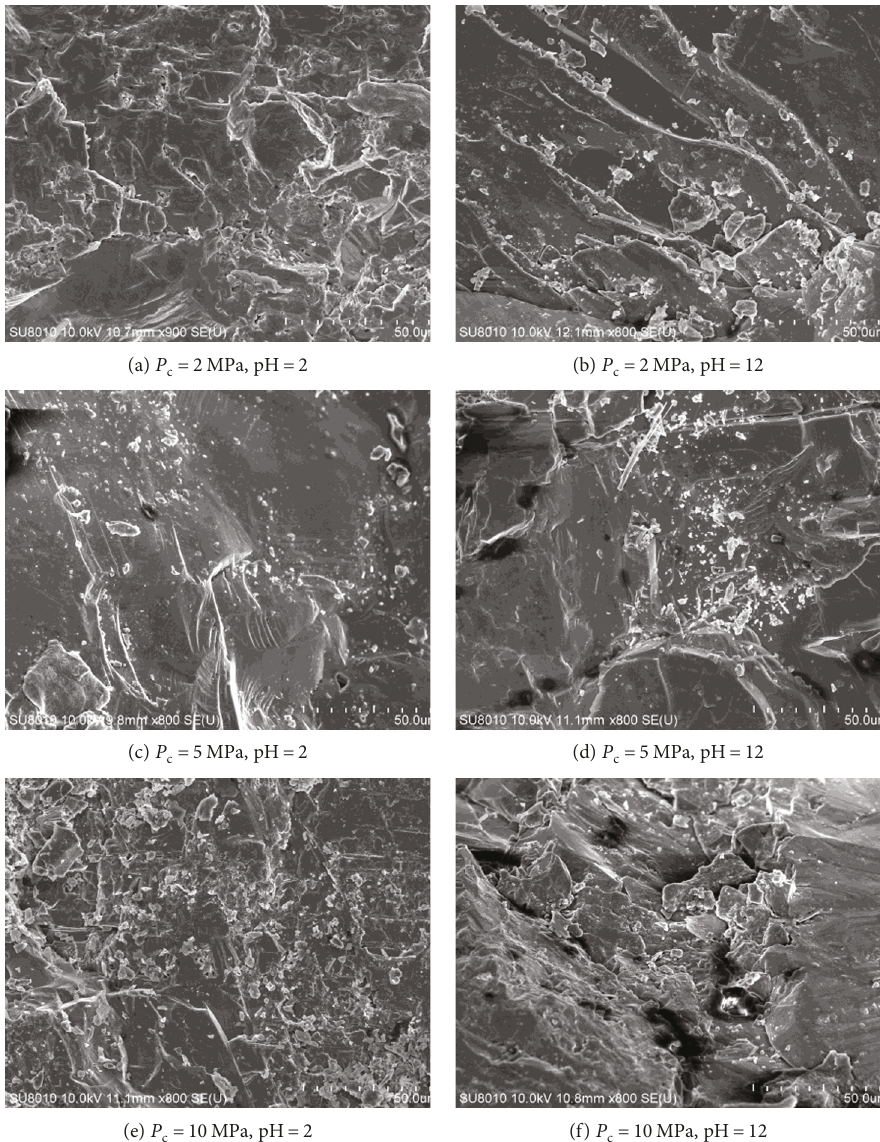
Figure 8: Photographs of the microstructures at the fracture surfaces of the samples after the creep